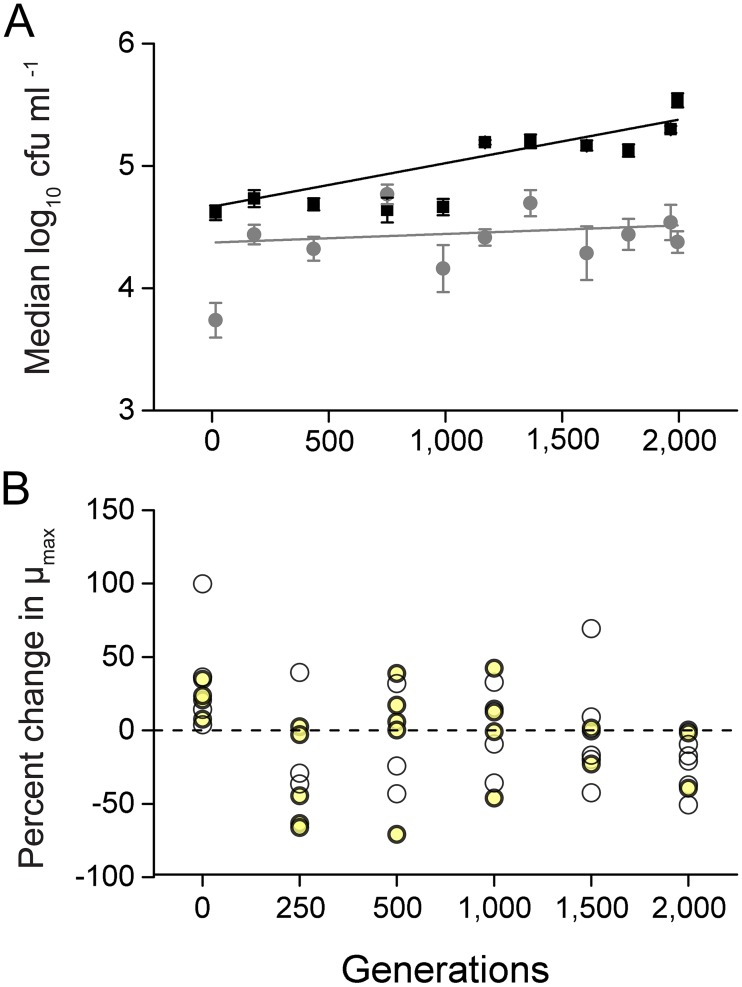
In the presence of amino acids, populations evolved an increased cell density and amino acid-dependency of their growth.(A) Median cell density of the populations that evolved in the presence (black boxes) or absence of AAs (grey circles) over the course of the evolution experiment. Each data point represents the median cell density (± 95% confidence interval) of eight replicate populations that are displayed as the log10 of the number of colony forming units per ml (CFU ml-1) at different time points of the experiment. The black and grey lines represent the exponential fit of the individual points (linear regression of fitted lines: P<0.05, n = 8). (B) Amino acid dependency of growth expressed as the mean difference in percentage between the maximal growth rates the AA-evolved populations achieved under AA-replete conditions and the growth rates, they achieved under unsupplemented conditions. Positive values indicate populations grow better in the absence of AAs, while negative values point to a growth advantage when AAs are present. Each circle represents the mean value of the corresponding replicate population and yellow circles highlight those populations, whose growth differed significantly between the two environments (FDR corrected paired samples t-test: P<0.05, n = 4).